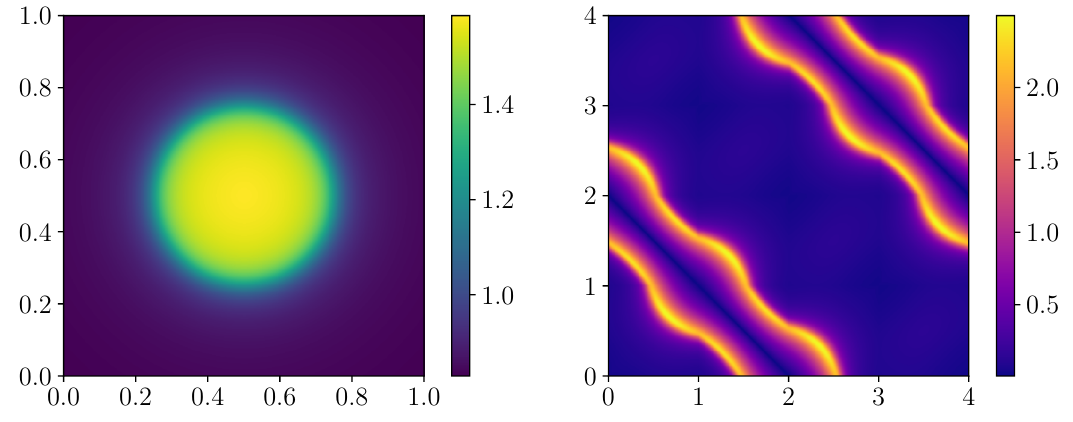
Figure 18 . Color maps of the probability distribution (6.5) used for the circular boundary example (left panel) and of the corresponding | ¯Γ[ C ] | in the ( p in , p out ) parameter space (right panel).